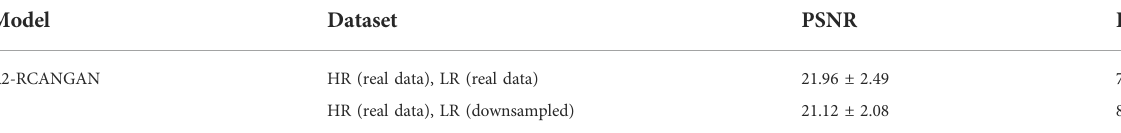
TABLE 2 Quantitative results (on the test set) based on training with different paired LR and HR images.